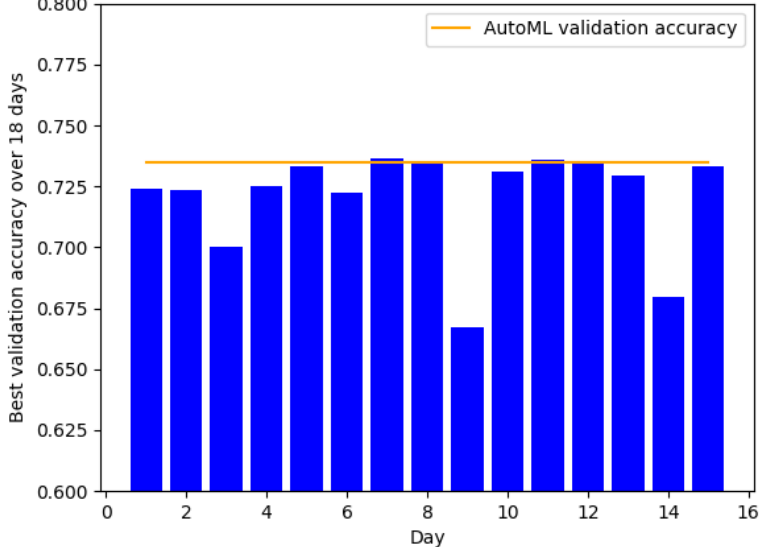
Figure 4. Validation accuracy over 15 days by the graduate student on the Cardiovascular Disease